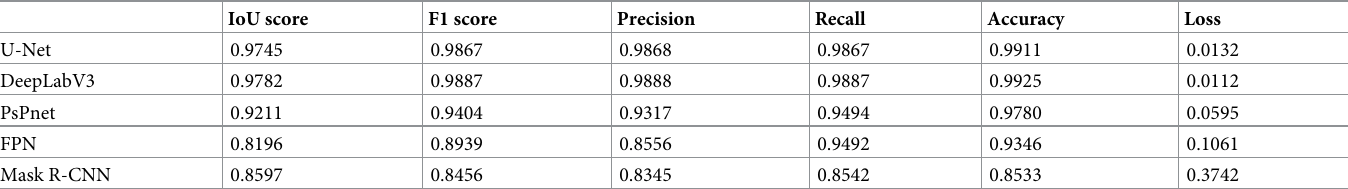
Table 3. Performance of the five models on wound segmentation and re-ep detection task.